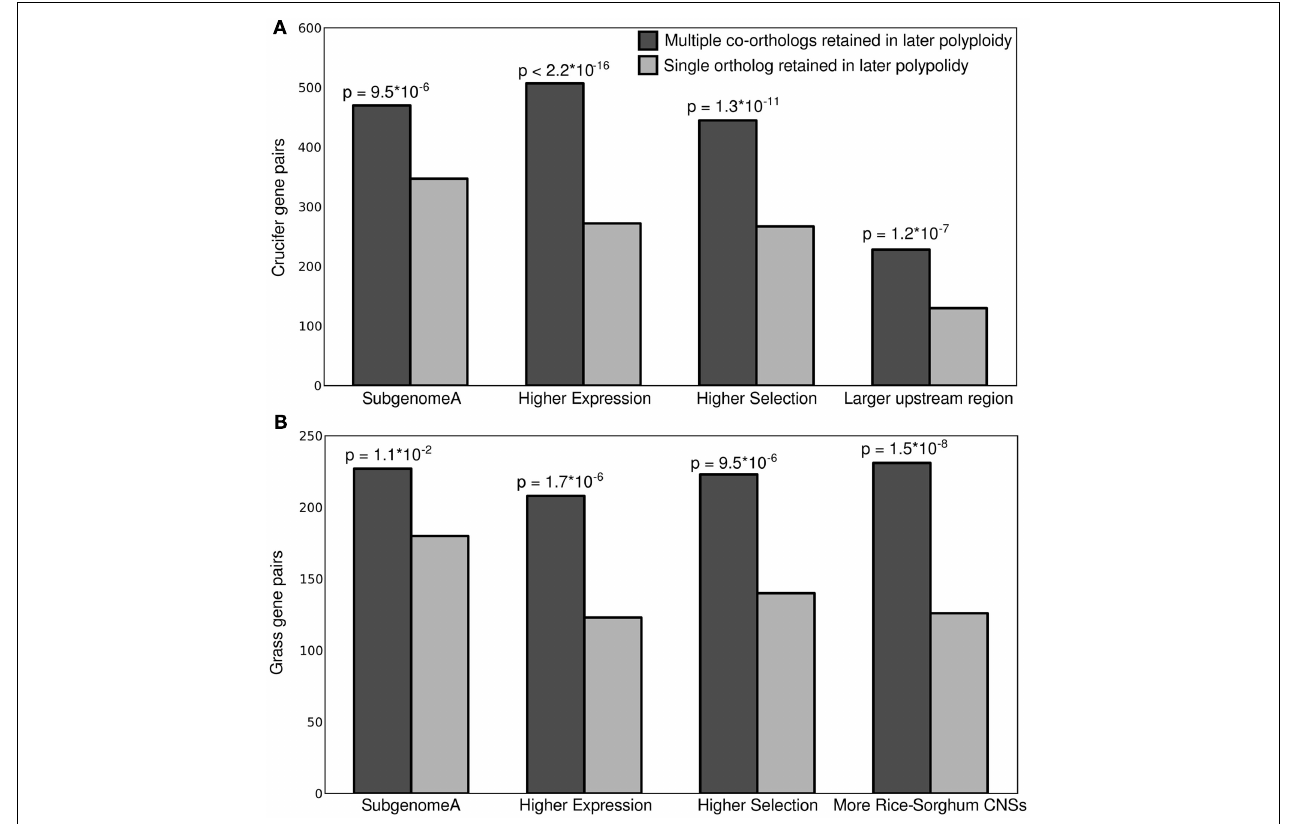
FIGURE 3 | Correlation between subsequent duplicate gene retention and a number of predicting factors including gene expression, ratio of non-synonymous to synonymous substitutions, and subgenome identity for (A) crucifer and (B) grass gene pairs. P -values relative to a 50/50 binomial